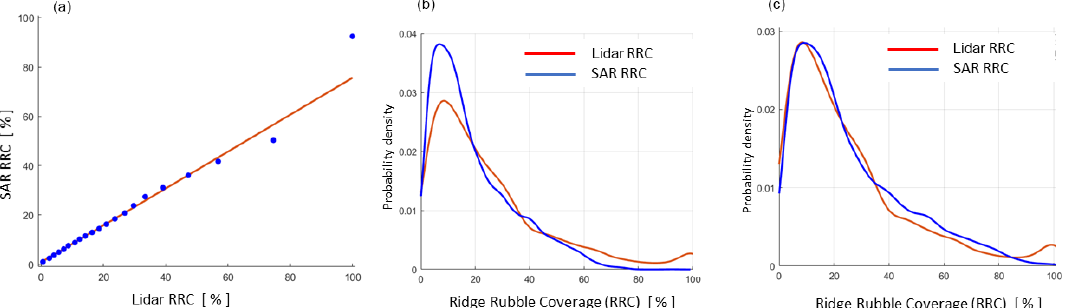
Figure 13. The quantile–quantile plot for the SAR and lidar datasets (a) . The SAR and lidar RRC distributions overlaid (b) . The scaled SAR and original lidar RRC distributions (c)